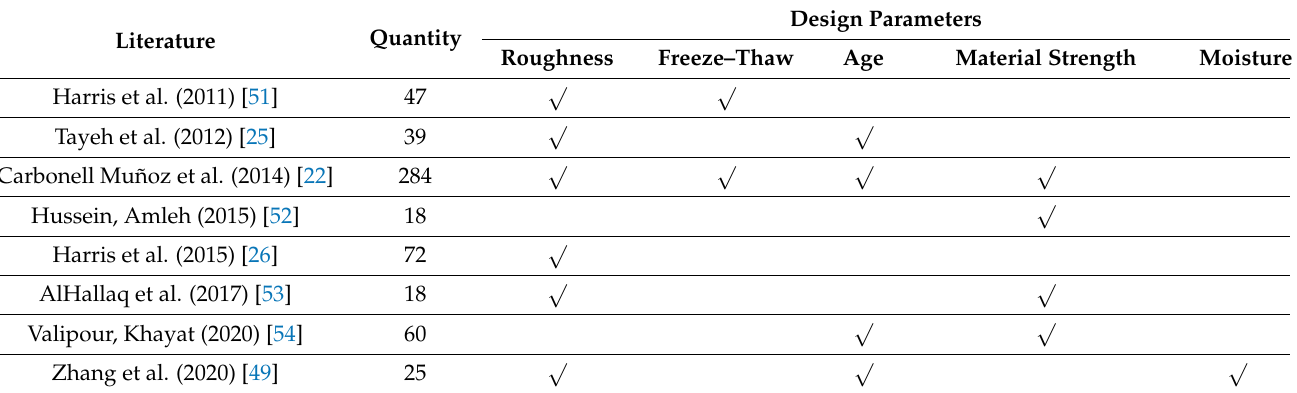
Table 3. Parameters considered in the collected splitting